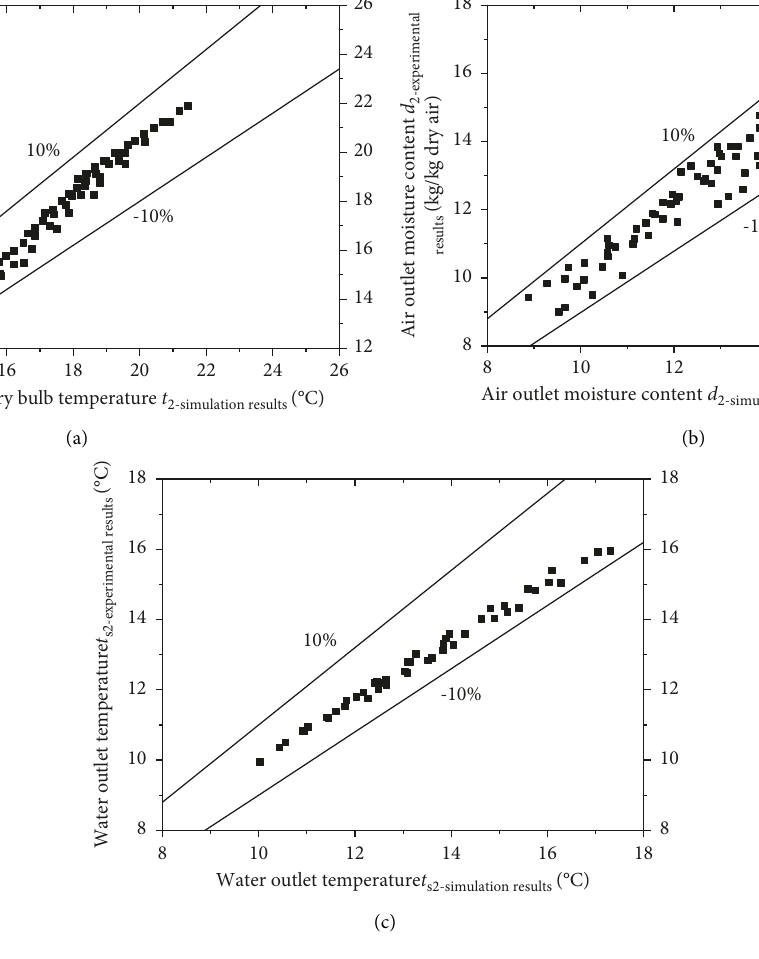
Figure 6: Comparison between experimental results and simulation results.